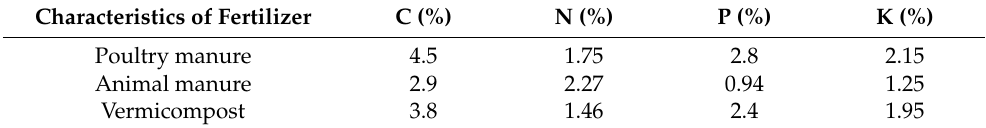
Table 4. Some characteristics of poultry and animal manure and vermicompost used in the experiment. Characteristics of